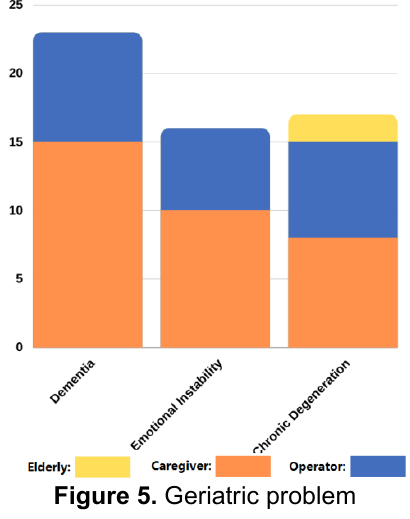
Figure 5. Geriatric